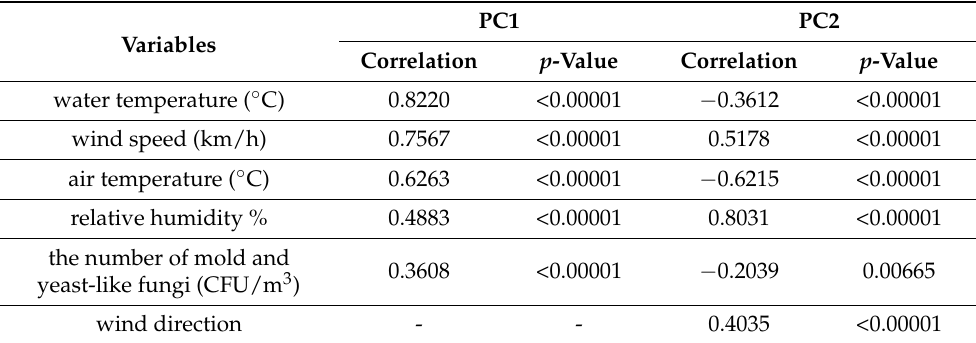
Table 2. The values of the correlation between PC1, PC2, and the variables used to build the model. PC1 Variables